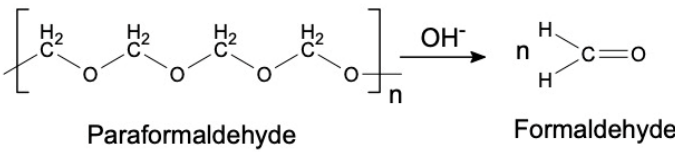
Figure 1. Depolymerization of paraformaldehyde [25].